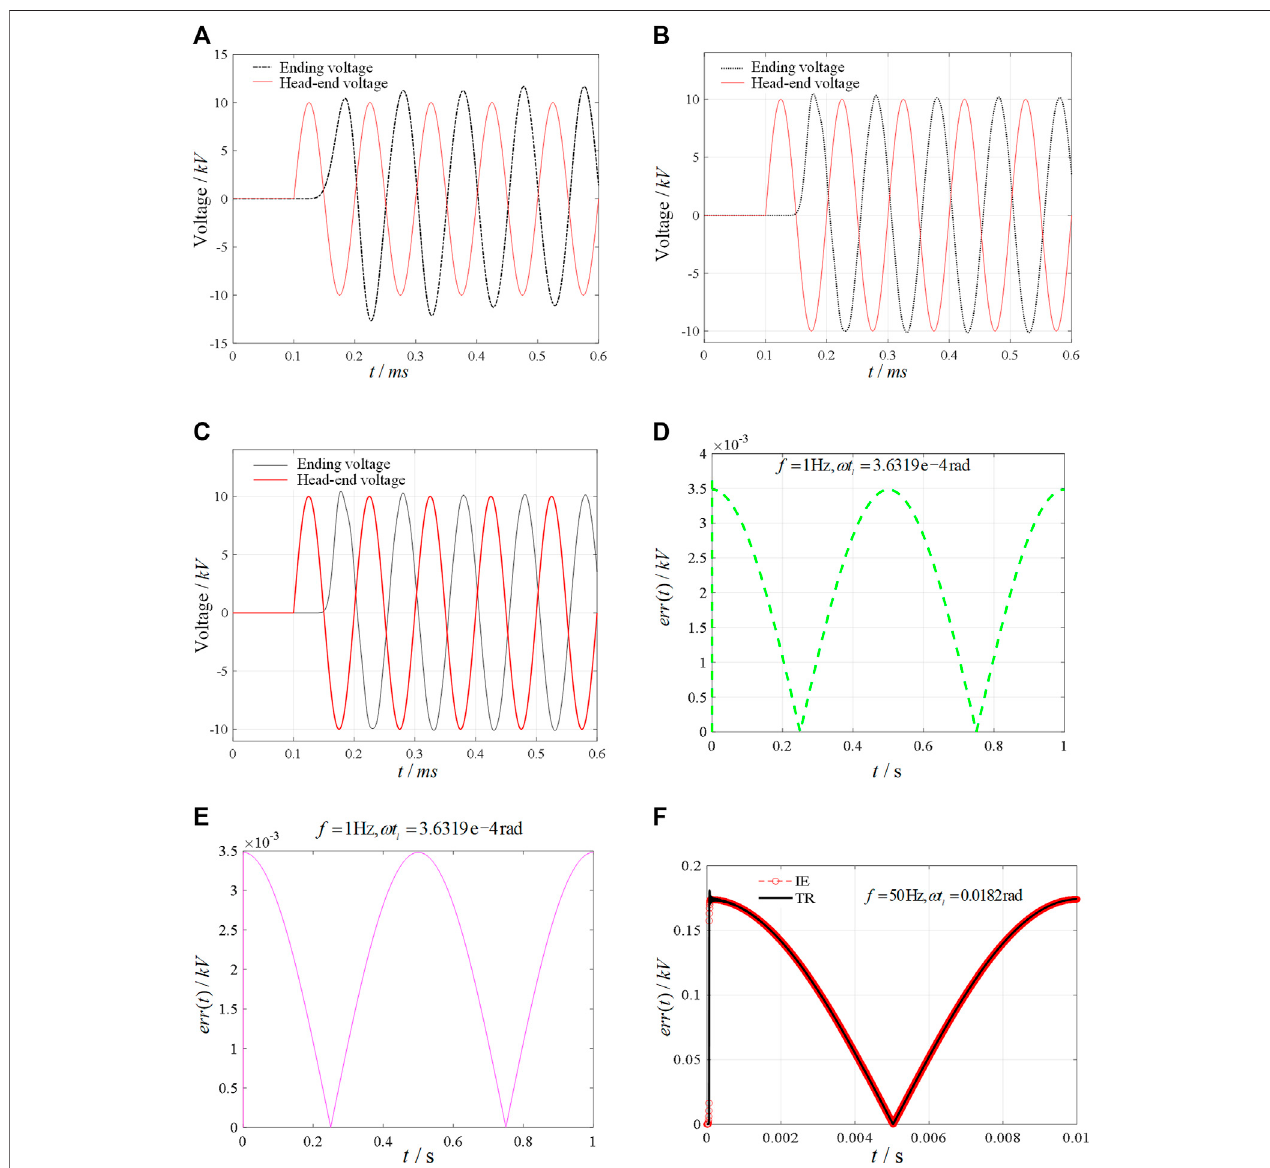
FIGURE 4 | Chained number and numerical algorithm analysis of lumped-circuits numerical simulation. (A) M (cid:1) 4 (the terminal resistance is 30 Ω ). (B) M (cid:1) 12 (the terminal resistance is 30 Ω ). (C) M (cid:1) 12 (the terminal resistance is 29.65 Ω ). (D) Amplitude-frequency responseerror curve ofthe TRalgorithm. (E) Amplitude-frequency response error curve of algorithm IE. (F) Amplitude-frequency response error curve of algorithms TR and IE.